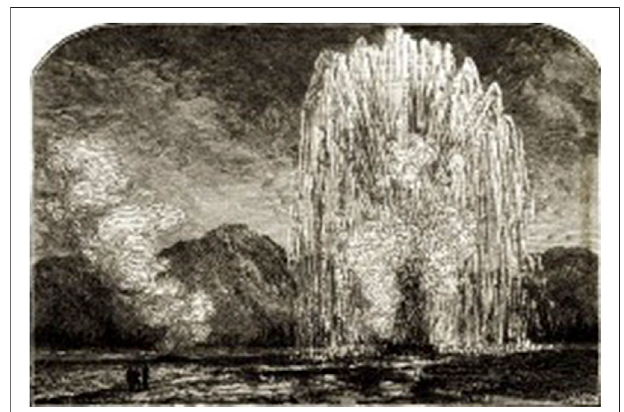
FIGURE1| WoodcutbyThomasMoranofthe “ Fan ” geyser.Featuredin Part 2 of Langford ’ s Wonders of the Yellowstone (1872).